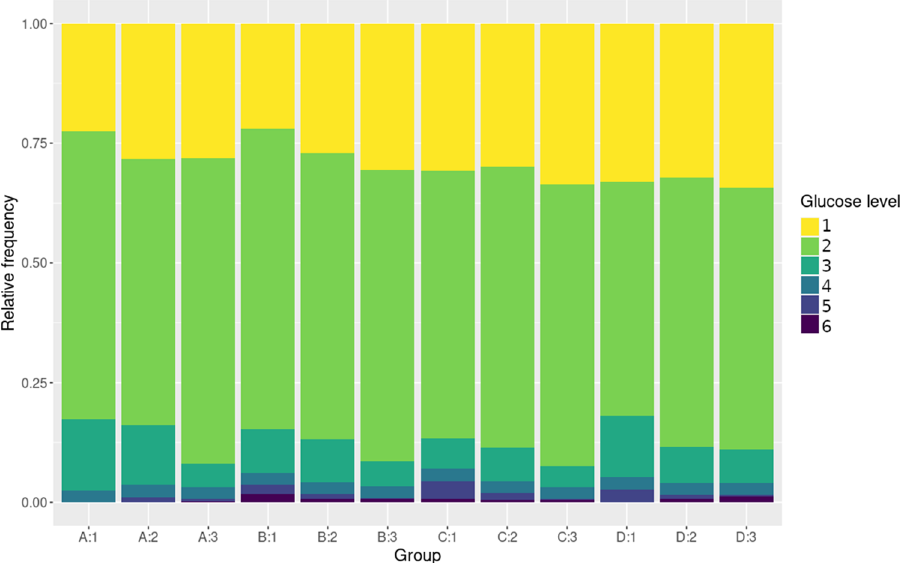
Figure 7. Levels of fasting glycemia per income and educational attainment. Relative frequency of individuals presenting each glucose level at each income and educational attainment